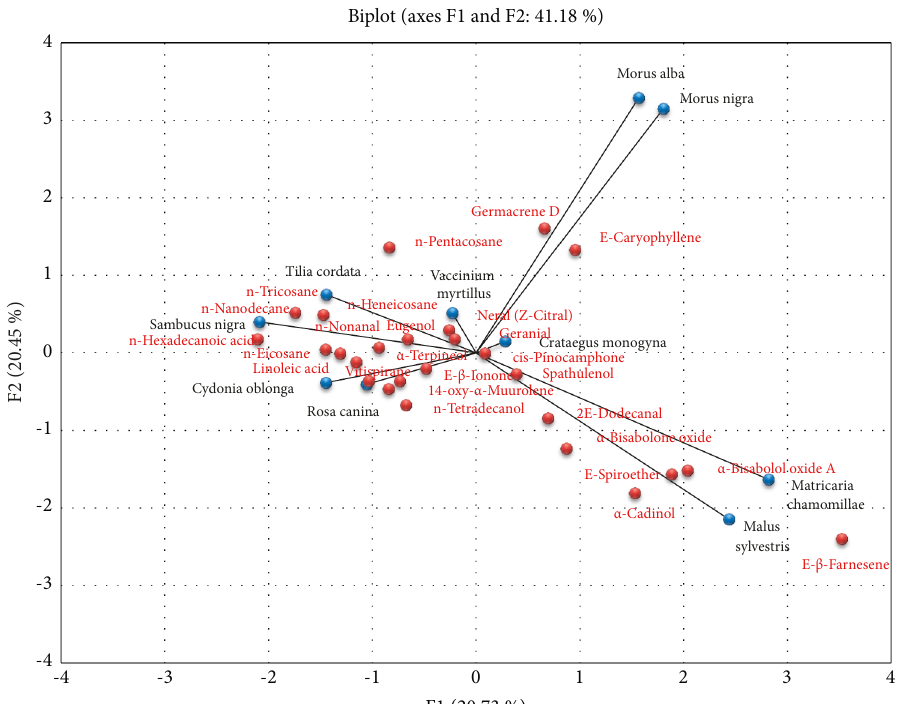
Figure 1: Diagram generated from the principal component analysis of volatile compounds found in ten plant species traditionally used as